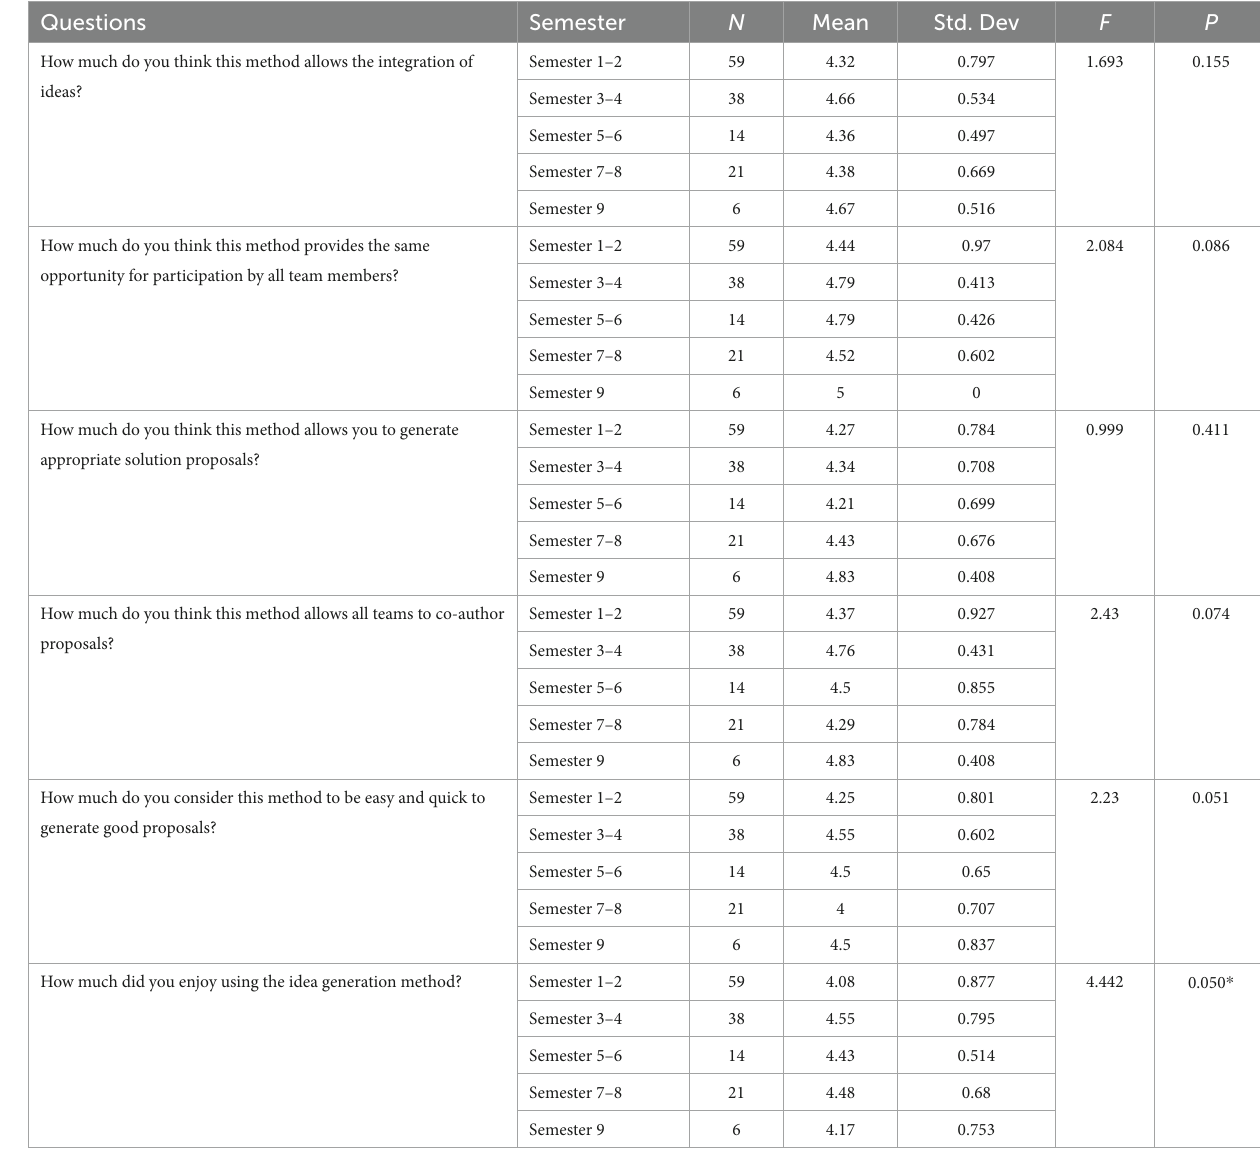
TABLE 4 Descriptive Statistical and ANOVA for